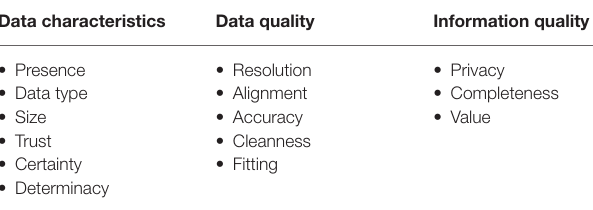
TABLE 3 | Data consistency for smart grid